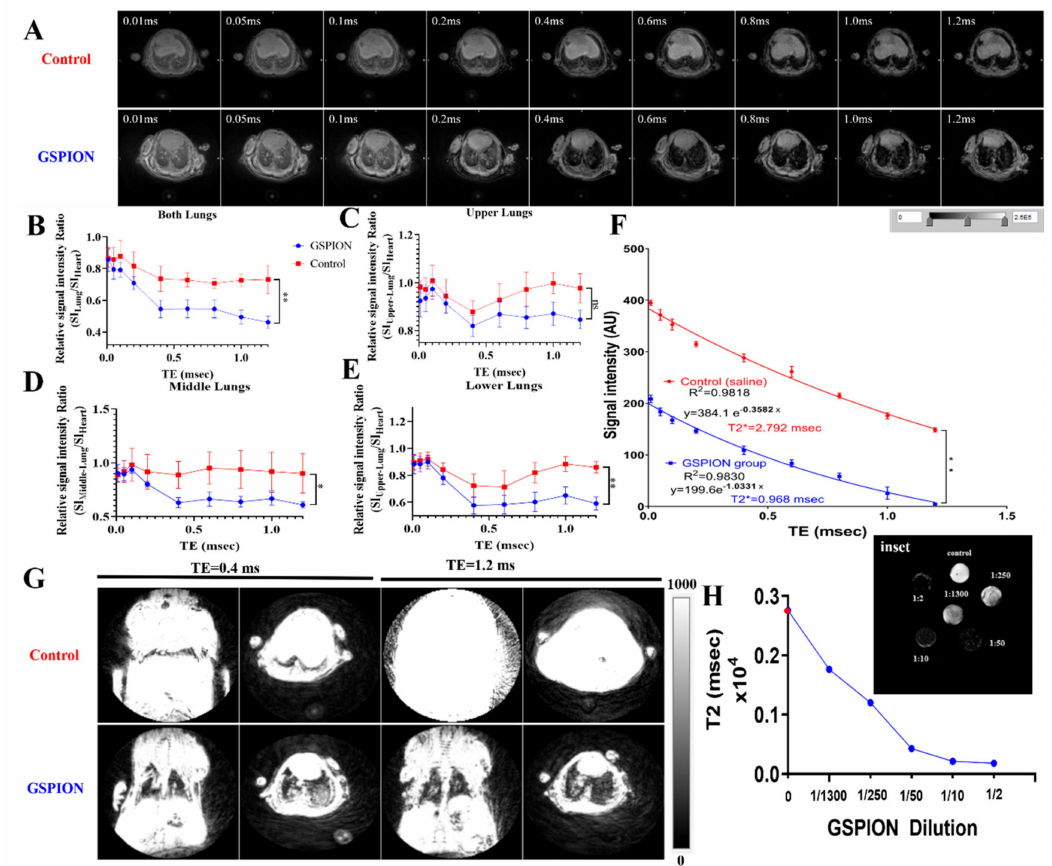
Figure 2. Non-invasive three-dimensional (3D) Ultra-short Echo Time (UTE) MR imaging of the lung for biodistribution. All MR images are at slice 71 for group GSPIONs (represented in blue) and control (saline, represented in red). ( A ). GSPION vs. Control (0.9% saline) sensitized mice imaged at di ff erent TEs between 0.01 to 1.2 msec. ( B ). Relative signal intensity ratio (SI Lung / SI Heart ) for the whole lung and heart was calculated using ROI, shown in supplementary Figure 2, to show the di ff erence in between the GSPIONs vs. control (saline) administered groups. The relative signal intensity ratio for GSPIONs group was lower in comparison to saline. ( C ) . Signal to noise ratio of the upper lung region for GSPION vs. control (saline) groups. ( D ). Signal to noise ratio of the middle lung region for GSPION vs. control (saline) groups. ( E ). Signal to noise ratio of the lower lung region for GSPION vs. control (saline) groups. ( F ). Signal Intensity decay curves of GSPION treated group in comparison to control (saline). Mono-exponential fitting equation and R 2 values are indicated for five mice in GSPION group and three mice in control group. The SIs were measured for all TEs ranging from 0.01 to 1.2 msec, which demonstrates an exponential decay of the order S = S0e-TE / T2*. Based on the equation, T2* was calculated for GSPION and control (saline) group( G ). 3D UTE volumetric rendering of GSPION sensitized and control mice at ultra-short TE 0.4 msec and conventional TE 1.2 msec. The lung in GSPION groups are visible from the signal contrast by the GSPIONs, while the saline (control) group lacks contrast from cardiac muscle and other tissues. The lungs are prominent in the GSPION treated group, while in the Saline treated group, we found them barely visible due to attenuation of signal by the accumulation of the GSPIONs, therefore showing their distribution in the lung. ( H ). The T2 (msec) of phantoms is represented as a function of the GSPION dilutions with control (in red) resembling 0.9% saline in agarose. ( inset ) T2 (msec) of di ff erent GSPION dilutions (resembling concentrations) showing relaxivity and darkening due to GSPIONs presence. For this experiment, N = 5 mice / group for GSPIONs and N = 3 mice / group for control (saline) was used, and Signal to noise ratio was represented as Mean ± SD. To assess the di ff erence between the relative signal intensity ratio of the two groups across di ff erent TE’s, an unpaired T test with Welch’s correction (not assuming equal SD) was used to determine the significance. ** p < 0.005, * p < 0.05, ns;